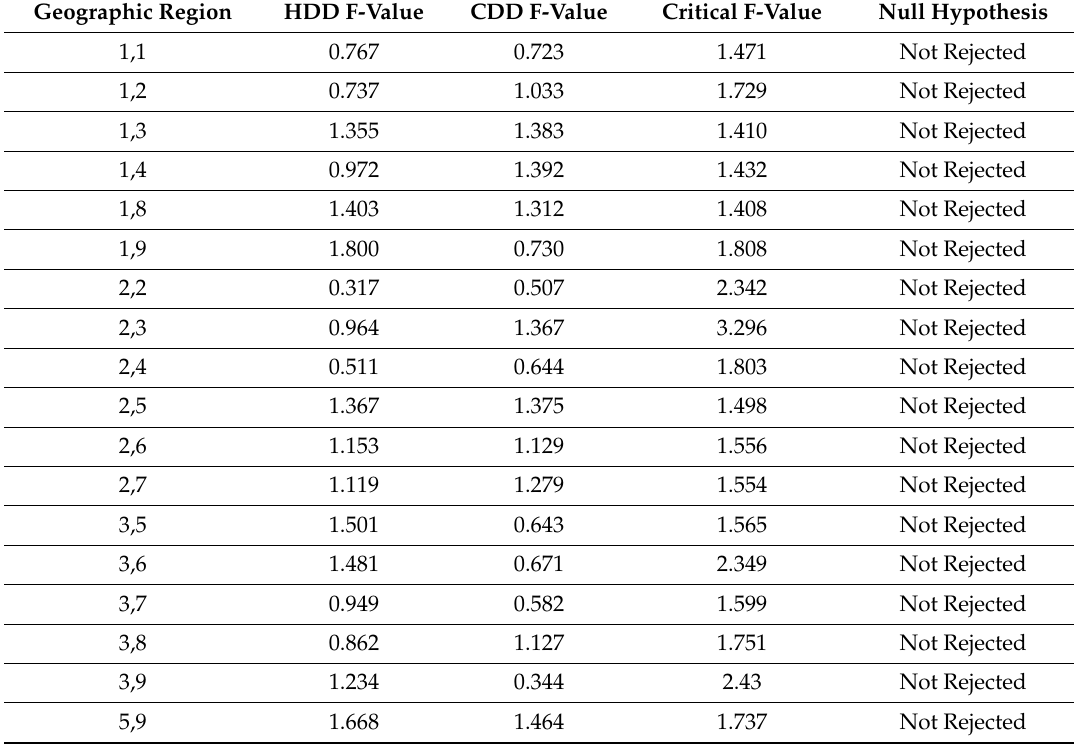
Table 4. Results of testing variability of two populations for both HDD and